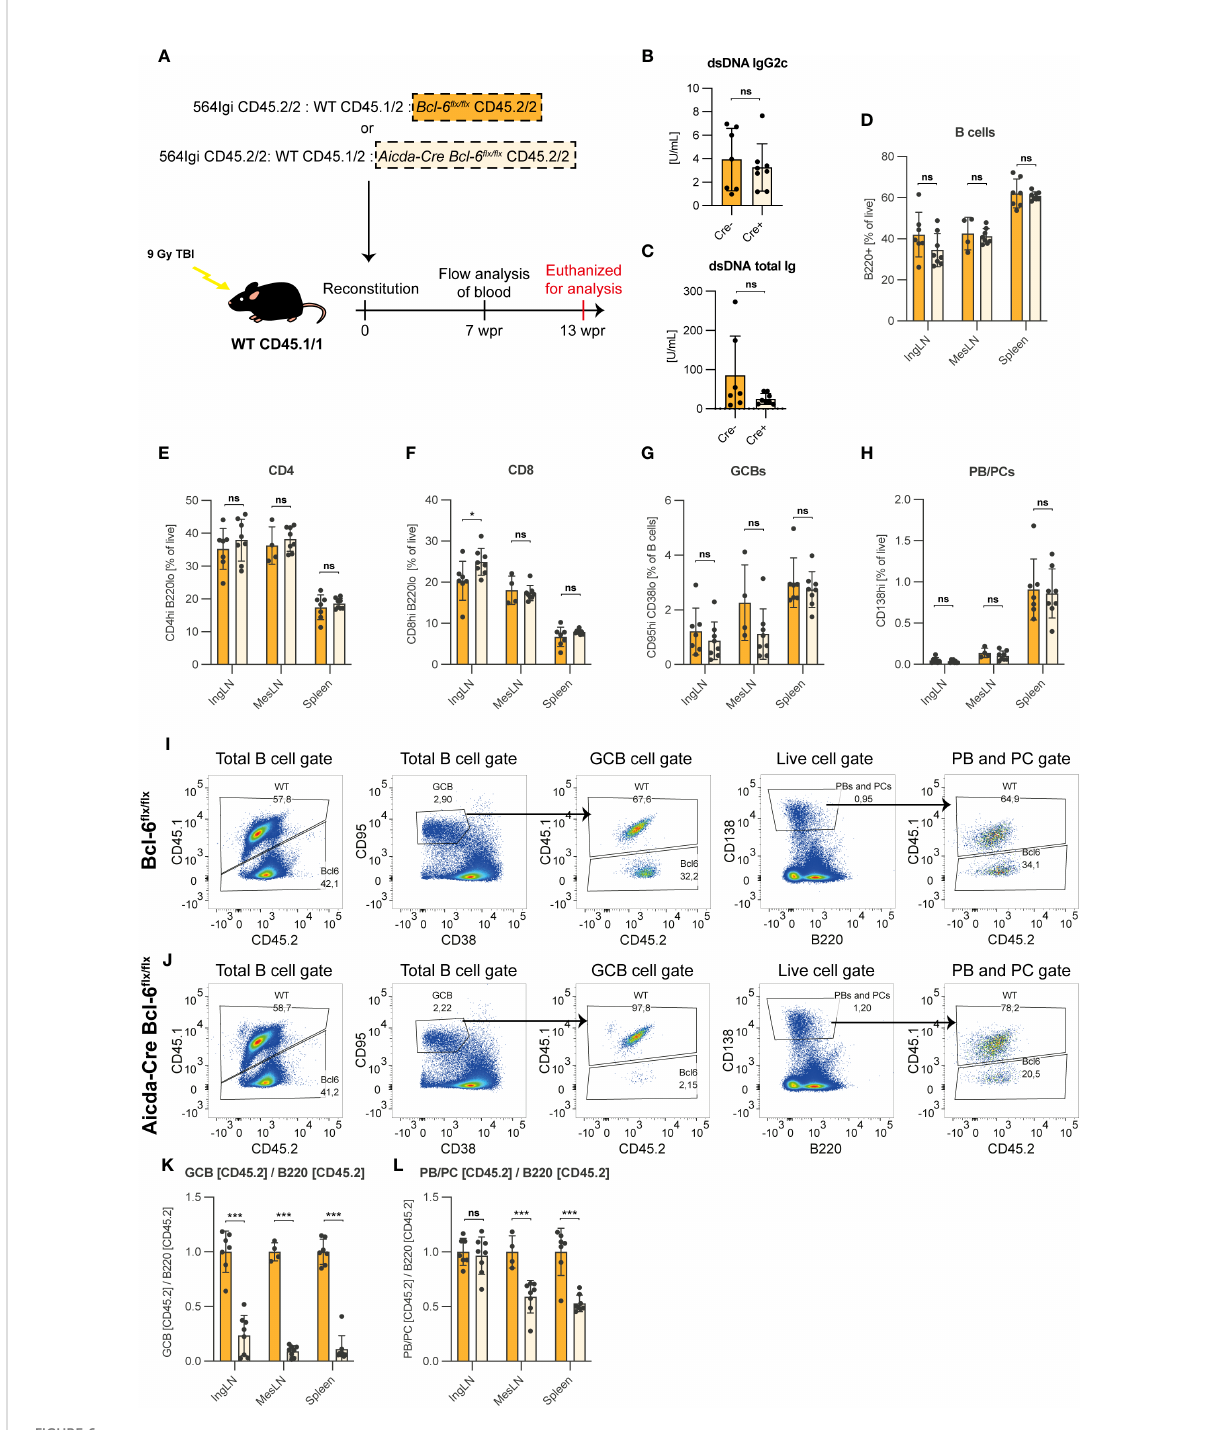
FIGURE 6 B cells harboring a GC block contribute to the PC lineage in a GC suf fi cient environment. (A) Schematic overview of the mixed bone marrow chimera setup. Lethally irradiated CD45.1/1 recipients were reconstituted with CD45.2/2 564Igi BM, WT CD45.1/2 BM and either Bcl-6 fl x/ fl x (Cre-, orange, n=7) or Aicda-Cre Bcl-6 fl x/ fl x (Cre+, light orange, n=8) (both CD45.2/2). (B) dsDNA IgG2c TRIFMA. (C) dsDNA total Ig TRIFMA. (D) Flow cytometric analysis of B cell frequencies (B220 + of live, singlets). (E) CD4 frequencies (CD4 of live, singlets). (F) CD8 frequencies (CD8 of live, singlets). (G) GCB frequencies (CD95 hi CD38 lo of B cells). (H) PB/PC frequencies (CD138 hi of live, singlets). (I) Representative bivariate plots with gates for Bcl-6 fl x/ fl x chimeras. (J) Representative bivariate plots with gates for Aicda-Cre Bcl-6 fl x/ fl x chimeras. (K) Ratio of CD45.2+ of GCB to CD45.2+ of total B cells. (L) Ratio of CD45.2+ of PBs/PCs to CD45.2+ of total B cells. The results are obtained from a single experiment with the number of mice given above. Bar graphs show mean ± SD. ns = p ≥ 0.05, *p < 0.05, ***p <